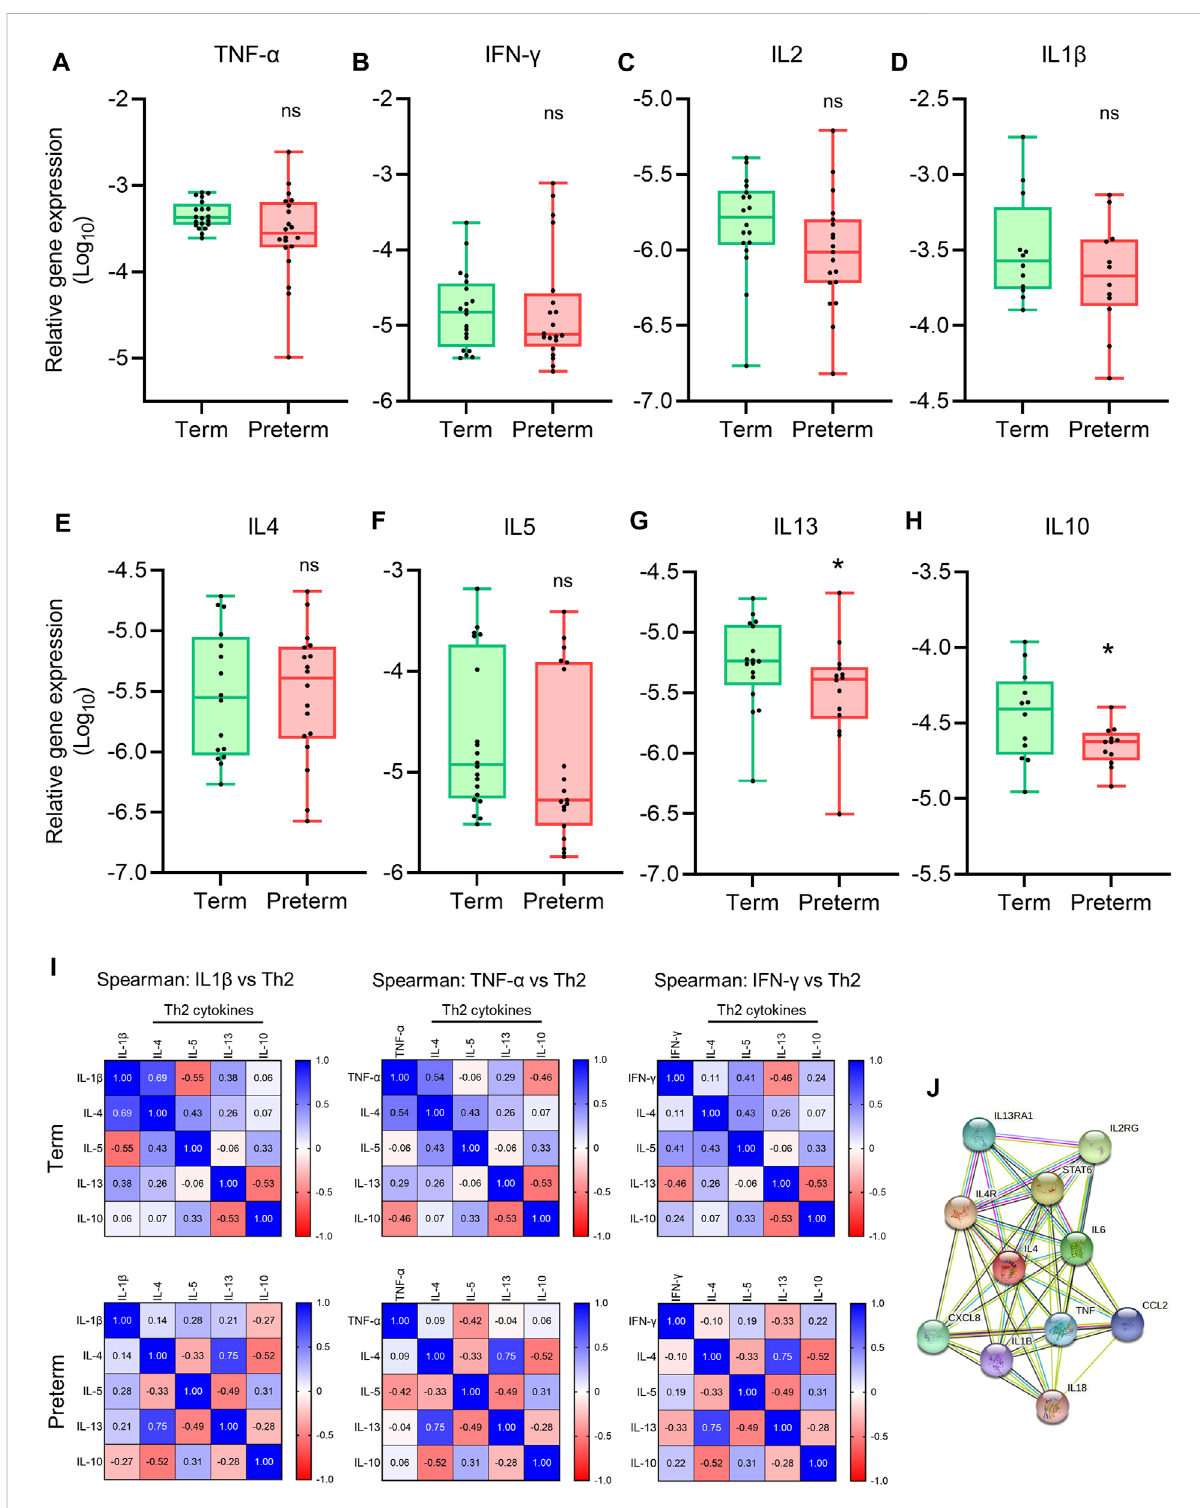
FIGURE 4 Th1 and Th2 gene expression and correlation analysis. (A-H) Box plots of qRT-PCR analysis showing gene expression (Relative to GAPDH ) of Th1 cytokines (A – D) and Th2 cytokines (E – H) in term and preterm placentas. n = 20 term and 20 preterm (A-C and E-G) , and n = 12 term and 12 preterm (D,H) . Data are presented as median and IQR with minima and maxima. Each dot represents an independent subject. * p < 0.05, ns = not signi fi cant, Mann-Whitney U test. (I) Spearman Rank test correlation matrices of Th1 cytokines IL1 β , TNF- α and IFN- γ vs Th2 cytokines IL4 , IL5 , IL13 and IL10 in term (upper panel) and preterm (lower panel) placentas. The numerical value in each small squire represents Spearman correlation coef fi cient ‘ r ’ . (J) STRING protein-protein interaction analysis (STRING, Version